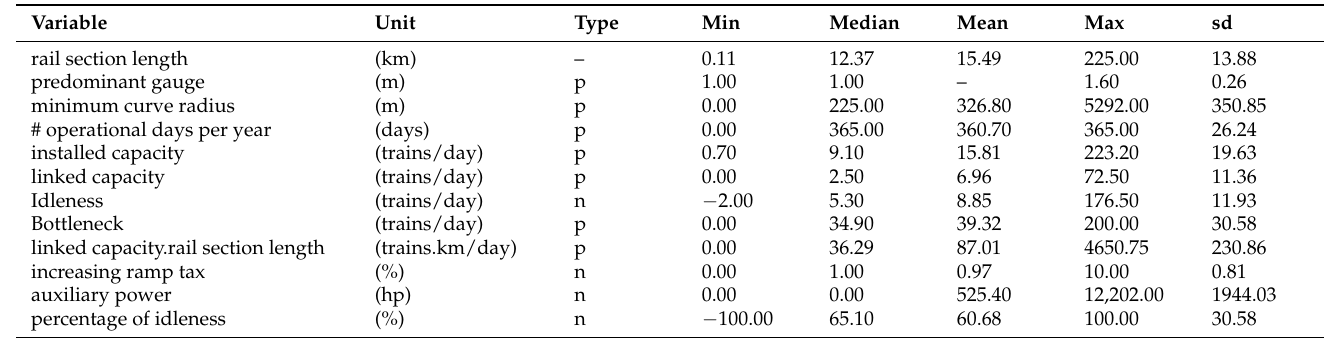
Table 2. Descriptive statistics on Brazilian rail